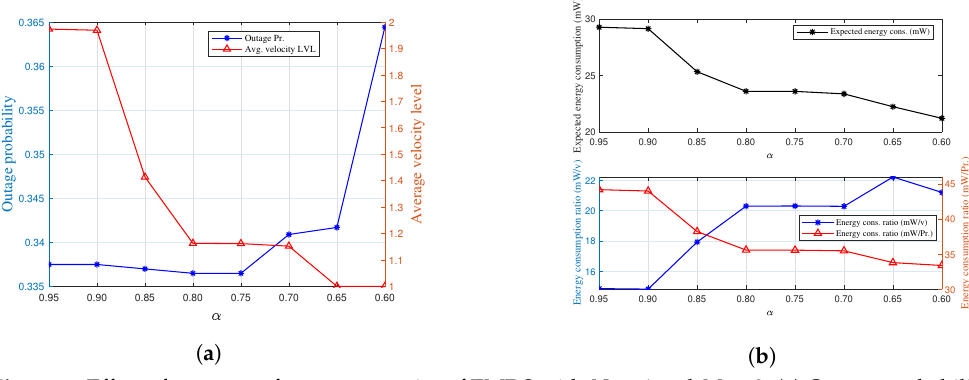
Figure 9. Effect of α over performance metrics of EMDS with N = 6 and M = 3; ( a ) Outage probability and average velocity level and ( b ) Expected energy consumption (mW), expected energy consumption per velocity level (mW/v), and expected energy consumption over 1 − P out